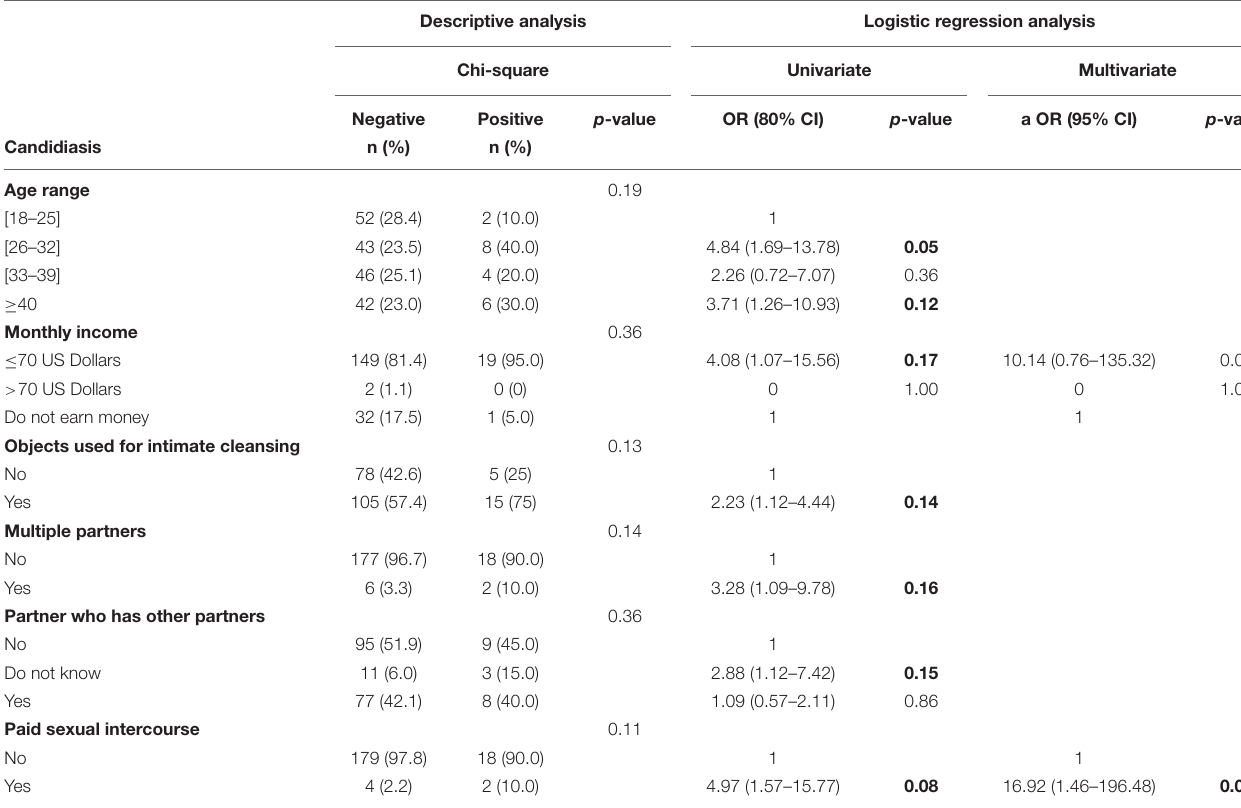
TABLE 5 | Descriptive and logistic regression analysis of factors associated with